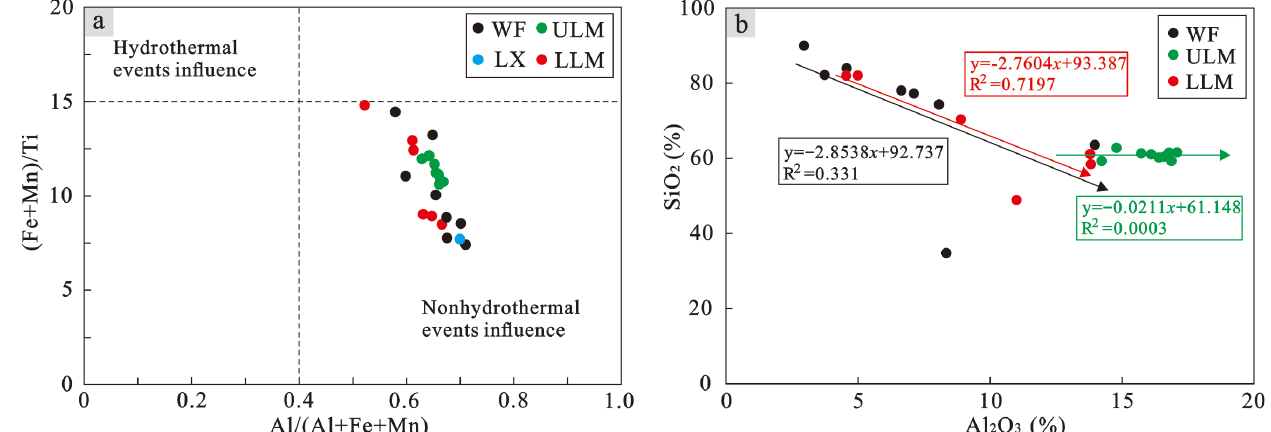
Figure 8. ( a ) Crossplots of (Fe + Mn)/Ti vs. Al/(Al + Fe + Mn) showing that the silica mainly had a nonhydrothermal origin. ( b ) Crossplots of SiO 2 vs . Al 2 O 3 showing a negative correlation in the WF and LLM, implying a mainly source of biogenic silica and no significant correlation in the ULM, implying that silica probably had a mixed biogenic and terrigenous clastic origin .